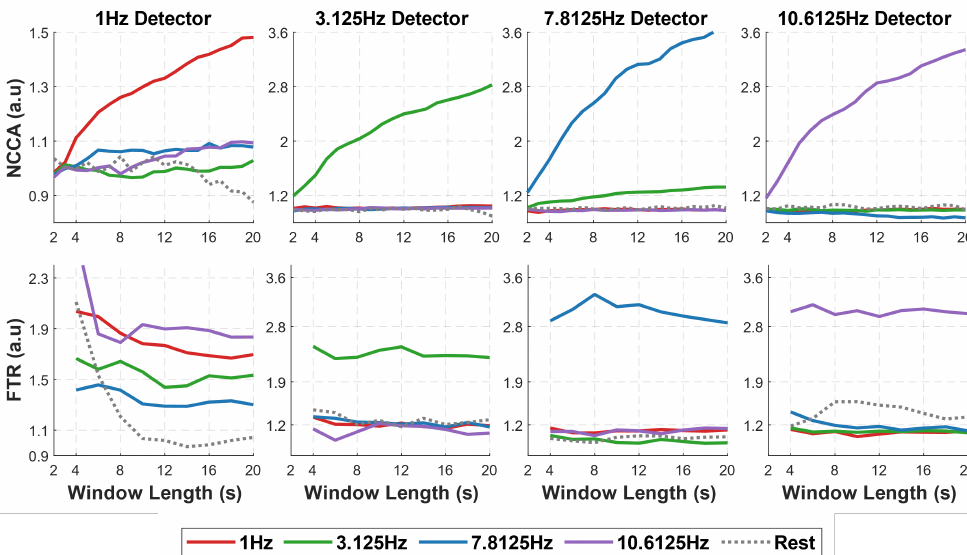
Figure 4. NCCA (top row) and FTR (bottom row) detectors at the four stimulation frequencies (from left to right: 1, 3.125, 7.8125, and 10.6125 Hz) applied to data segments relative to the four stimulation frequencies and to adjacent rest data as a function of the data window